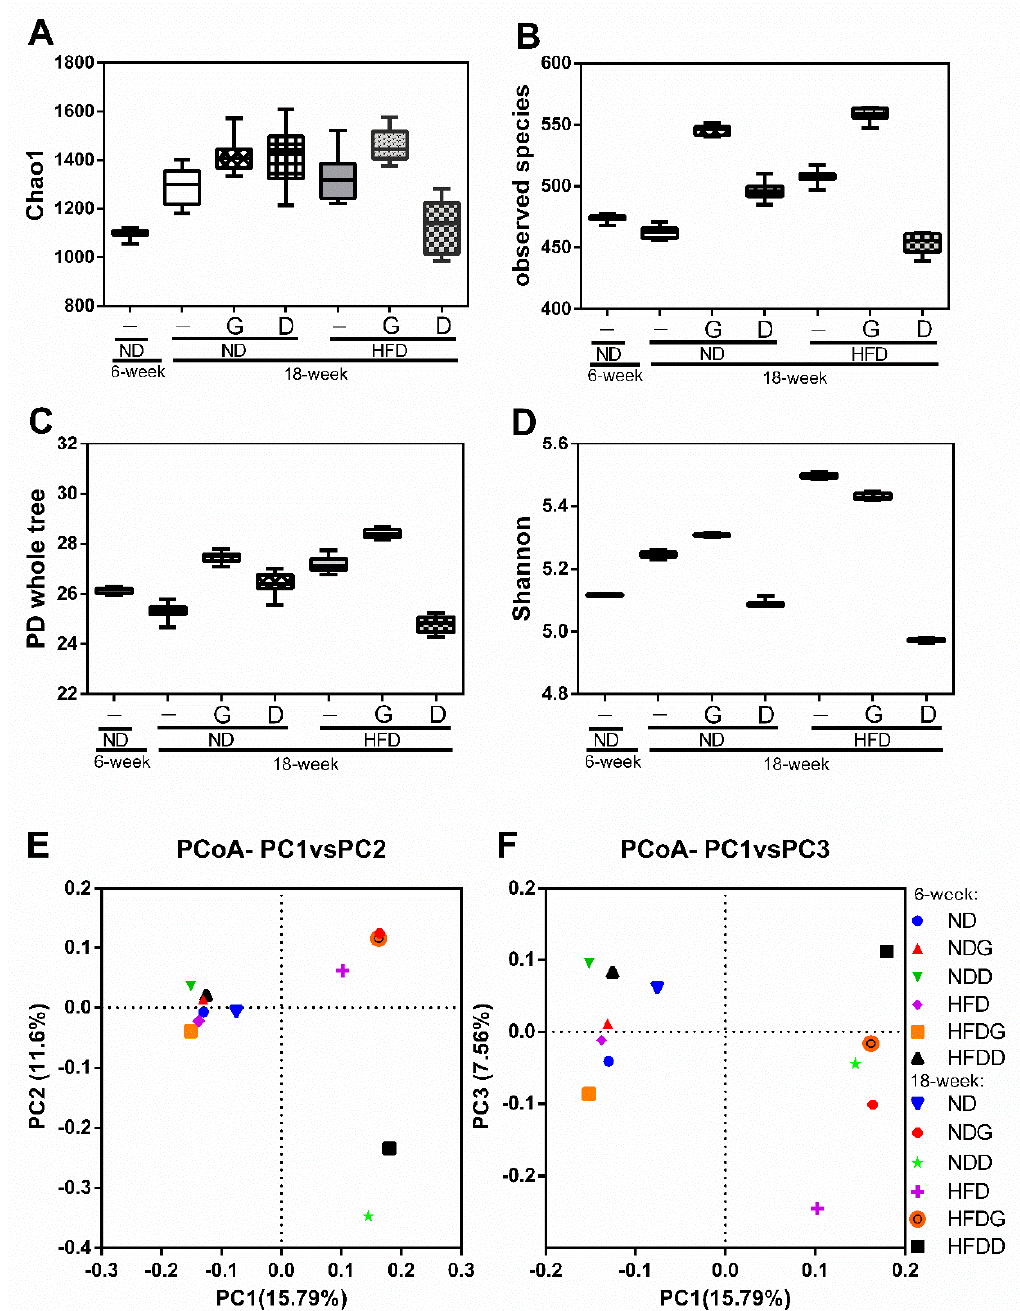
Figure 7. Effects of garlic supplementation on the gut microbiome. The taxa richness of the gut microbiome assessed by α -diversity analyses using Chao1 value ( A ), observed species index ( B ), PD whole tree index ( C ), and Shannon index ( D ). The data represent the median and range of ten alpha rarefaction values. The species compositions of the gut microbiomes were assessed by β -diversity analyses using principal coordinate analysis (PCoA) of the unweighted UniFrac distance matrices, which is showed in PC1 vs. PC2 ( E ) and PC2 vs. PC3 ( F ). Each dot in (E) and (F) represents the beginning (6-week) or ending point (18-week) of the experiment for each group ( n = 8).